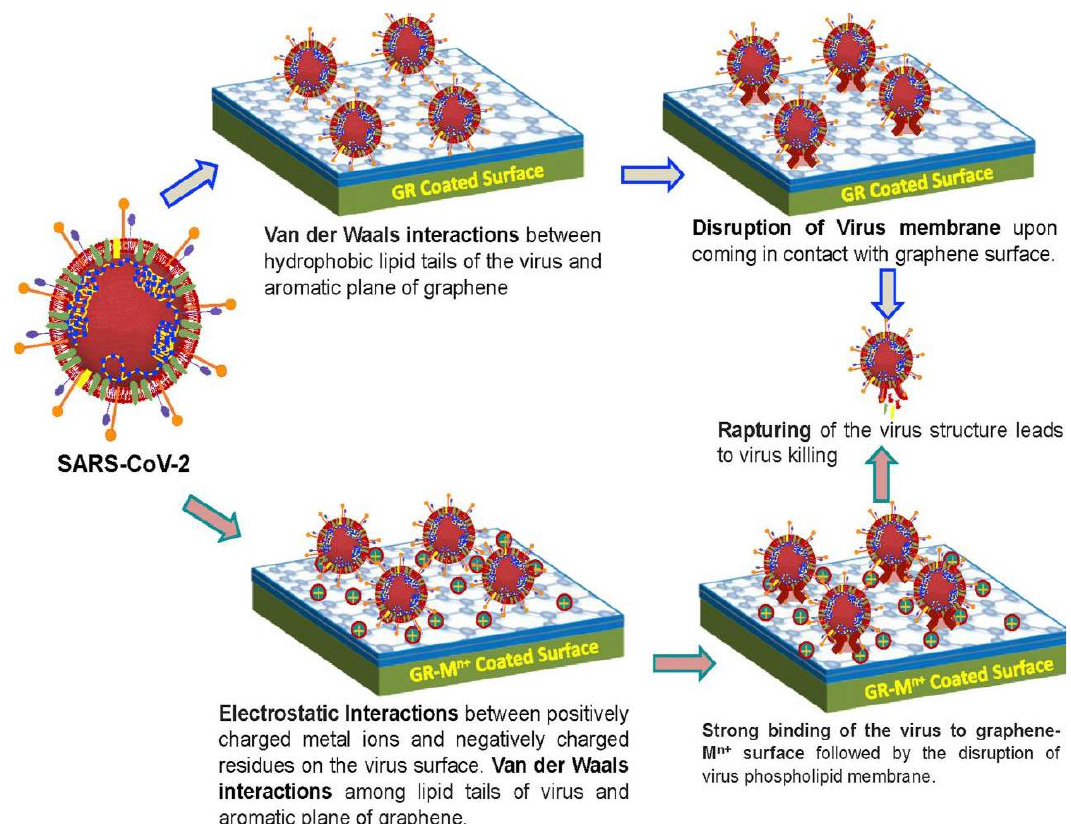
Scheme 4. Representation of the probable role of G and G metal ion-coated surfaces in hindering substrate infection from viruses such as SARS-CoV-2. Taken from [120].